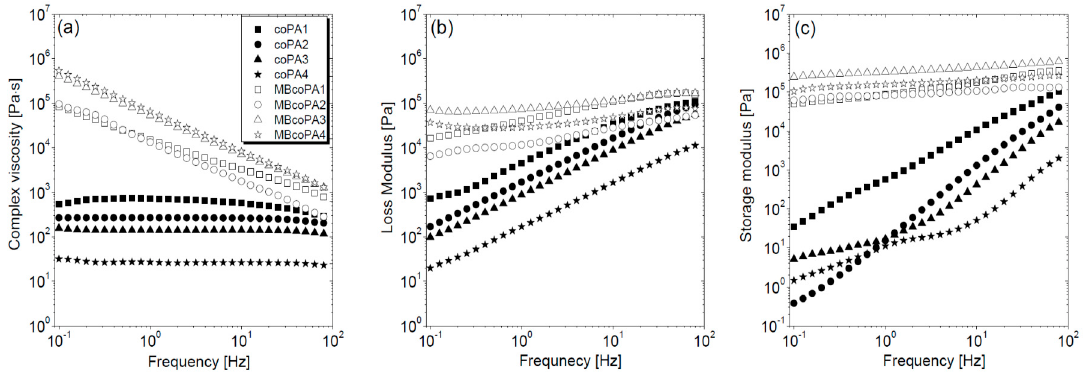
Figure 1. ( a ) Complex viscosity; ( b ) loss modulus G’’ and ( c ) storage modulus G’ in the frequency dependence for the neat coPAs and their masterbatches containing 7 wt % multi-walled carbon nanotube (MWCNT).